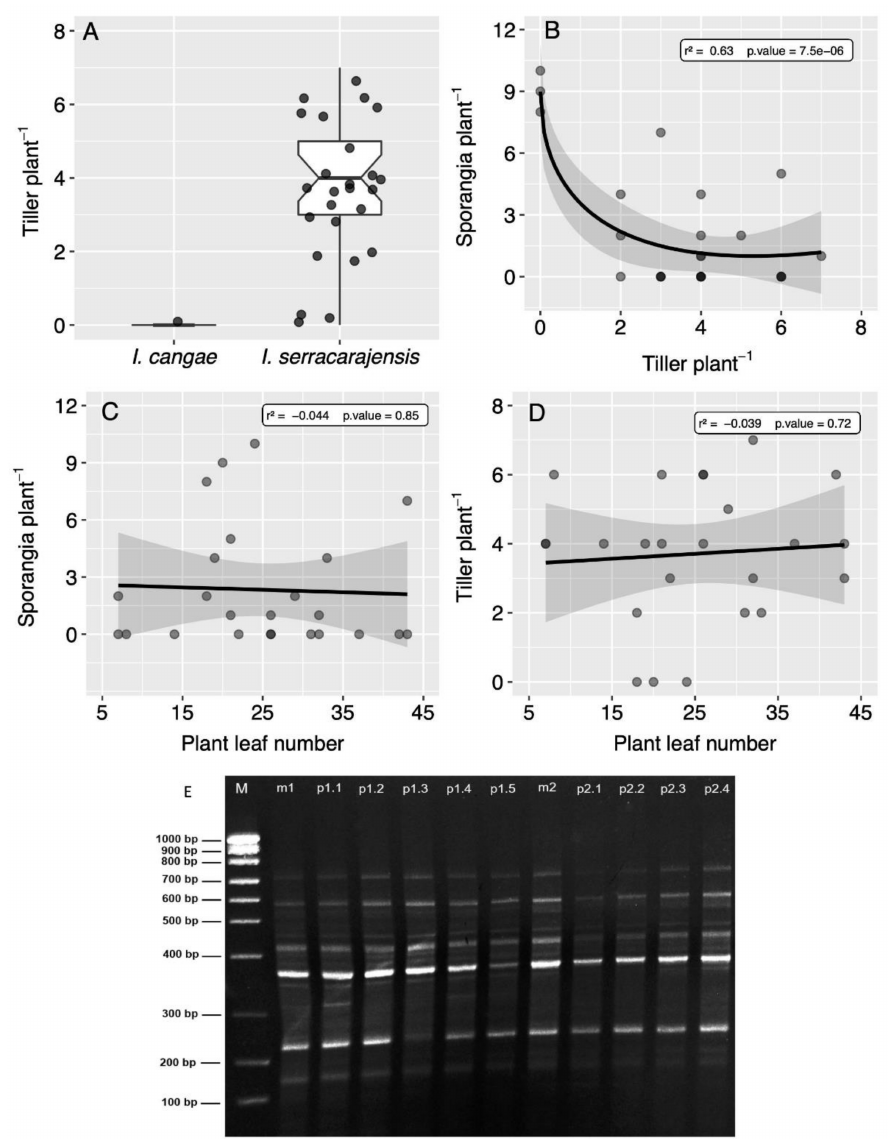
Figure 6. The tillering rate of 12-month-old plants of Isoëtes cangae and Isoëtes serracajensis ( A ) and the relationship between sporangia and tillers per plant ( B , y = − 6.9x 0.5 + 1.51x + 8.98), sporangia and leaf number ( C , y = − 0.013x + 2.65, nonsignificant model) and tiller and plant leaf number ( D , y = 0.014x + 3.35, nonsignificant model). ( E ) Gel electrophoresis pattern of ISSR amplification. M: Size marker; m1: mother plant (1); p1.1 to p1.5 refer to progenes of the mother (1); m2: mother